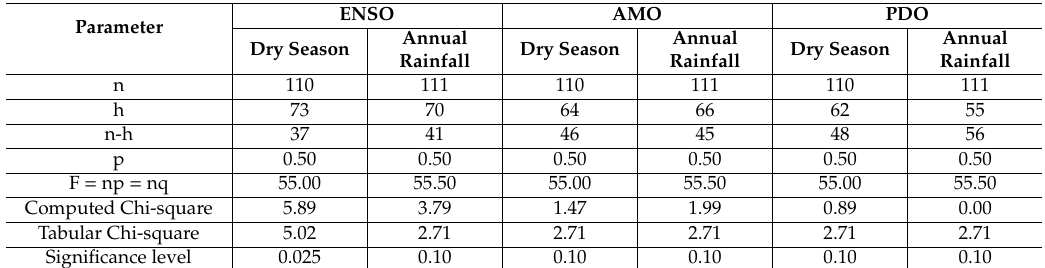
Table 2. Test statistics for the correspondence of rainfall anomaly to ENSO, AMO, and PDO. Parameter